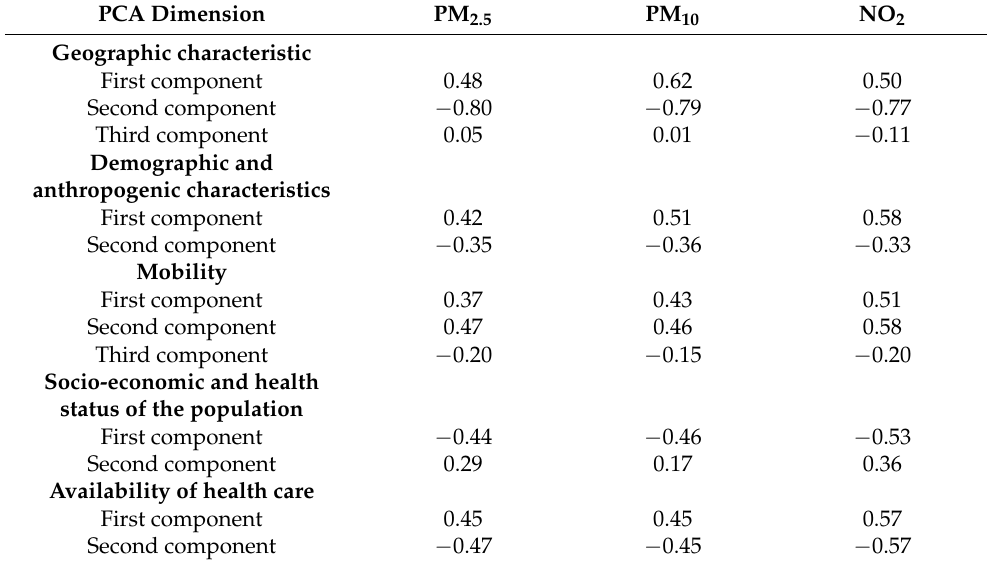
Table 3. Spearman correlation coefficients among pollution variables and components resulted from the principal component analysis for the five dimensions (geographic characteristic, demographic and anthropogenic characteristics, mobility, socio-economic and health status of the population, availability of health